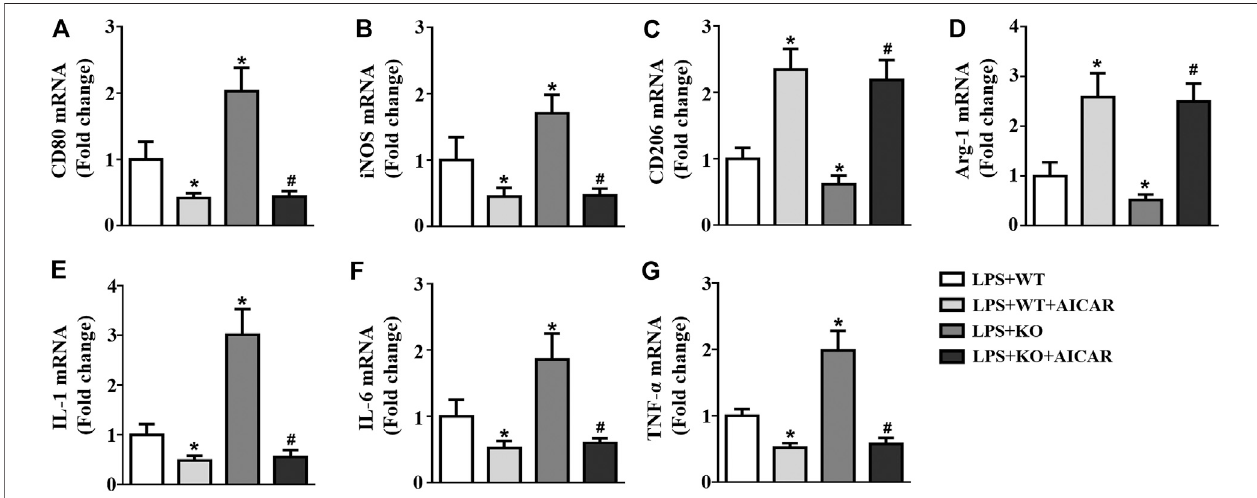
FIGURE11 | AMPK activation abolishes Il12a deletionmediated M1 macrophage polarization RT-PCR analysis ofCD80 (A) , iNOS (B) , CD206 (C) , Arg-1 (D) , IL-1 (E) , IL-6 (F) and TNF- α (G) mRNA expression in each group (n (cid:1) 4). * p < 0.05 compared with the LPS + WT group; # p < 0.05 compared with the LPS + KO group.